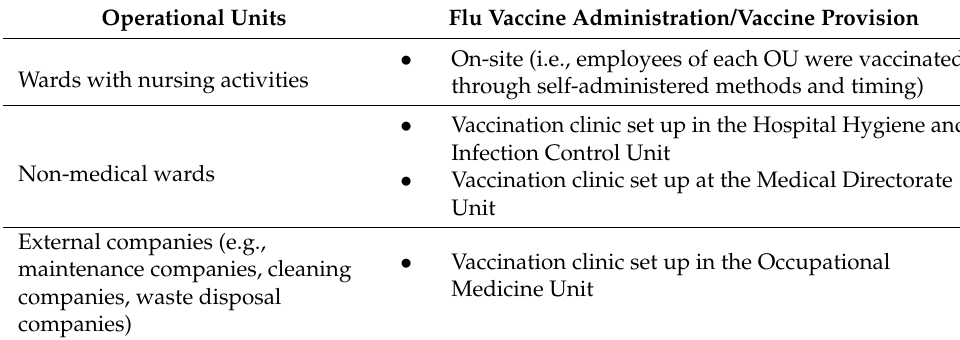
Table 5. Mode of flu vaccine